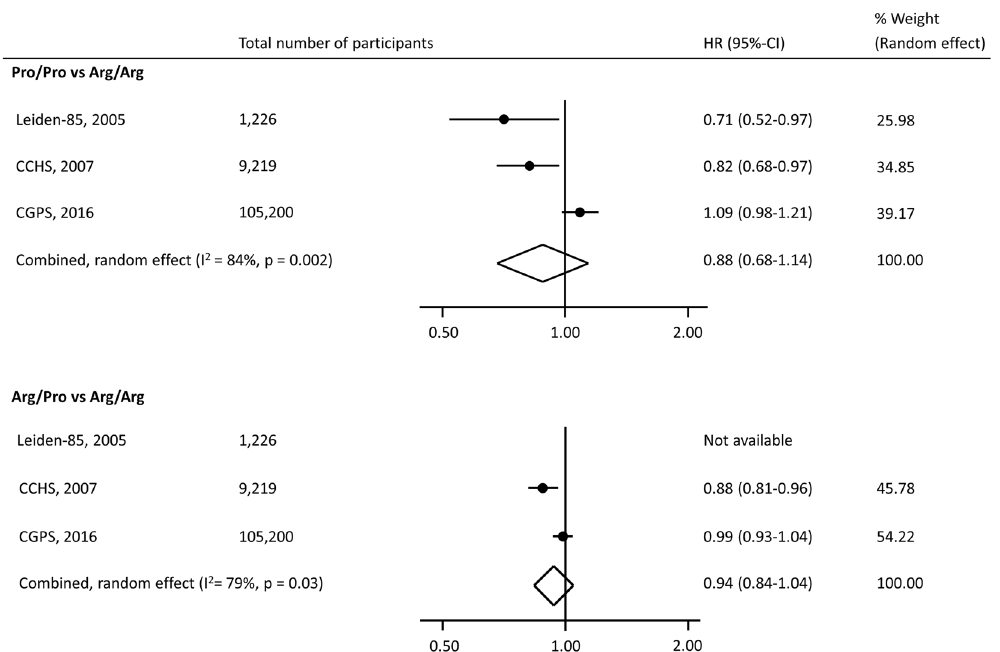
Figure 2. Meta-analysis of hazard ratios for all-cause mortality according to TP53 Arg72Pro genotype in 3 longitudinal studies. Hazard ratios were adjusted for sex and age. The hazard ratio for Arg/Pro vs. Arg/Arg was not reported in the Leiden 85-plus Study. CCHS; Copenhagen City Heart Study. CGPS; Copenhagen General Population Study. CI; Confidence interval. HR; Hazard ratio. Leiden-85; The Leiden 85-plus